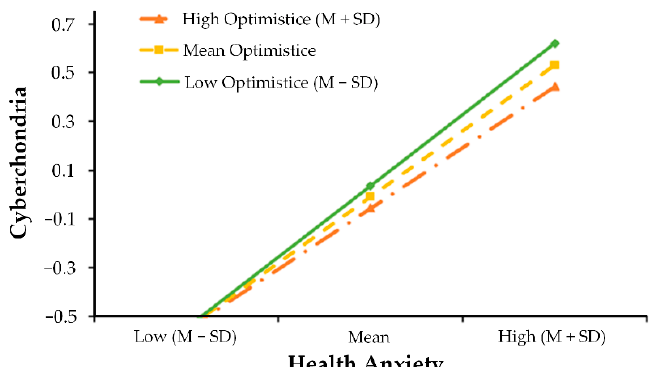
Table 5. Conditional indirect effect analysis at levels of the Moderator (optimism).